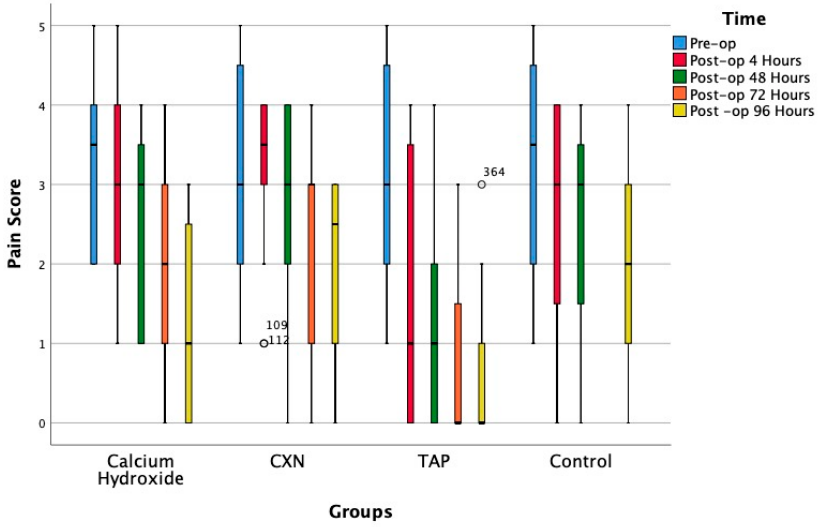
Figure 3. Box plot showing median (and range) pain scores in the four groups. The Tukey’s HSD test for multiple comparisons revealed that at 4 hrs there was a significant difference in pain scores of Group 3 and Group 2, and at 48 hrs and 72 hrs there was a significant difference in the pain score of Group 3 when compared with other groups. Lastly, at 96 hrs, there was significant difference in the pain scores of Group 3 in comparison with the Group 2 and Group 4. The Dunnett’s test showed a significant difference in the pain score of Control group (Group 4) and Tri-antibiotic group (Group 3) at 48 hrs, 72 hrs and 96 hrs (Table 3). Figure 4 summarizes the effects of the medications on postoperative pain over time.